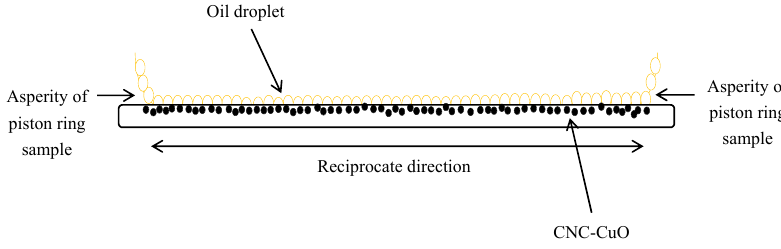
Figure 20. Front view of CNC-CuO based nano lubricant mechanism.